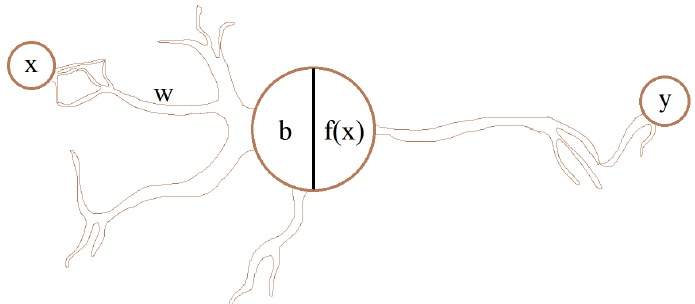
Figure 1. Neural